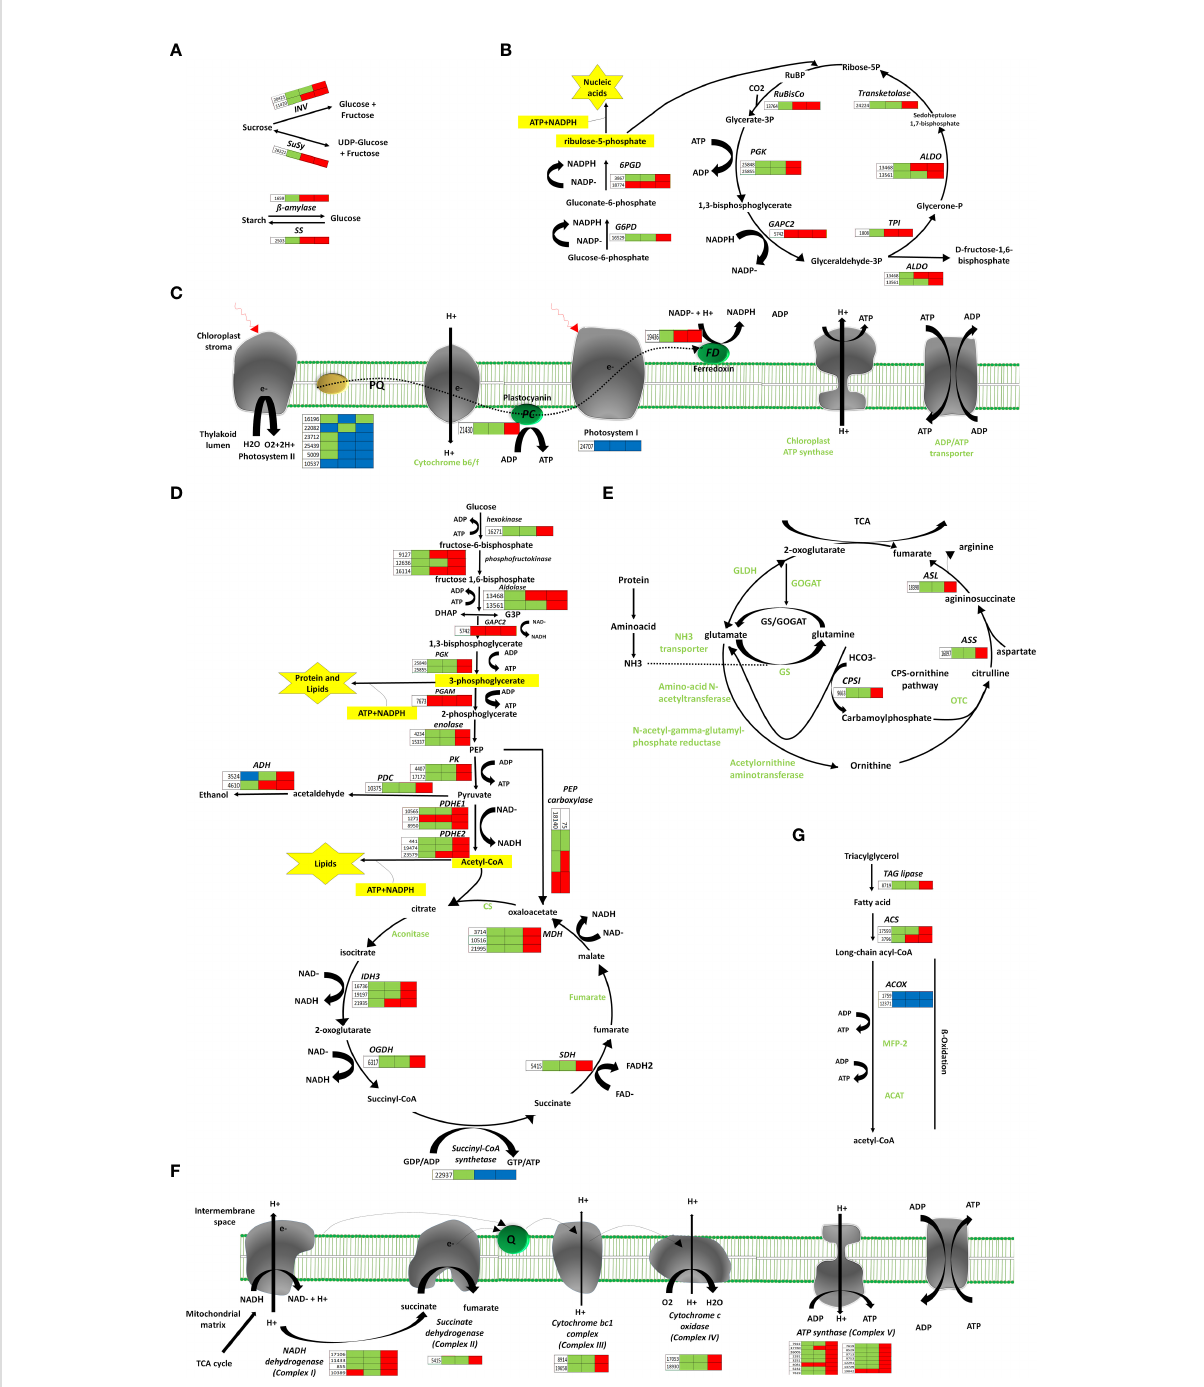
FIGURE 3 Pathways of energy-associated metabolic changes. (A) Starch and sucrose metabolism, (B) Oxidative pentose phosphate and Calvin cycle, (C) Photosynthesis remodeling, (D) Glycolysis, TCA, Fermentation, (E) N-assimilation, (F) Oxidative phosphorylation, (G) Fatty acid degradation. Red color indicates upregulation; bule color indicates downregulation; while green color indicates no regulation. Three blocks in each heatmap for sepal gene-expression indicate regulation at three development time points (12, 48 and 96 HAP) after pollination relative to un-pollinated sample